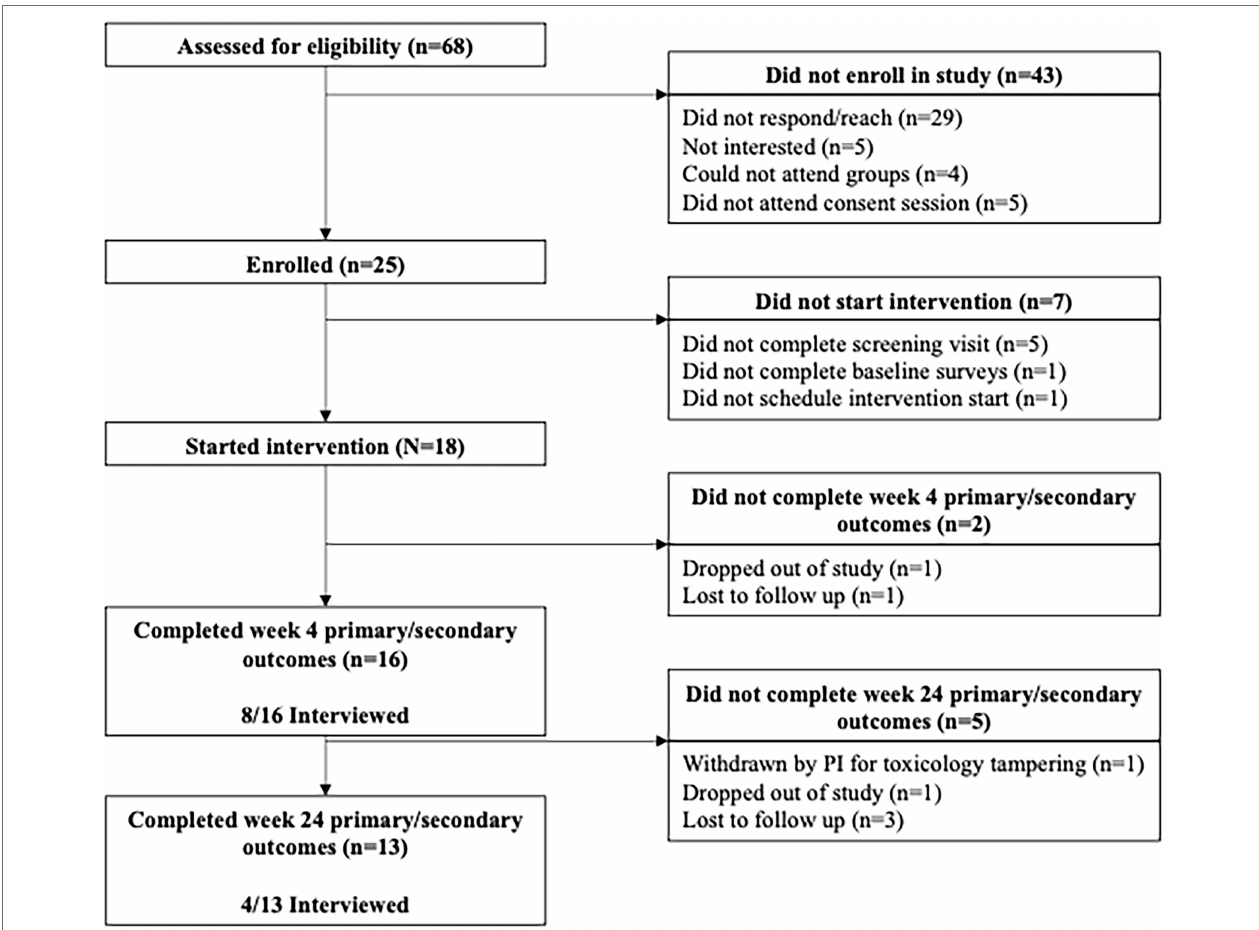
FIGURE 2 | Consort diagram.